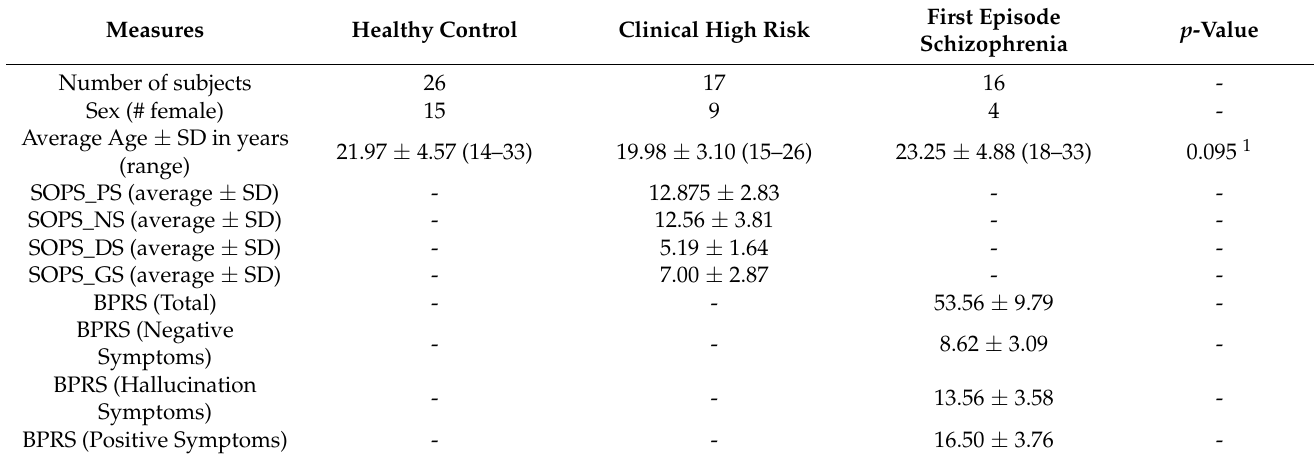
Table 1. Clinical and demographic measures of the study